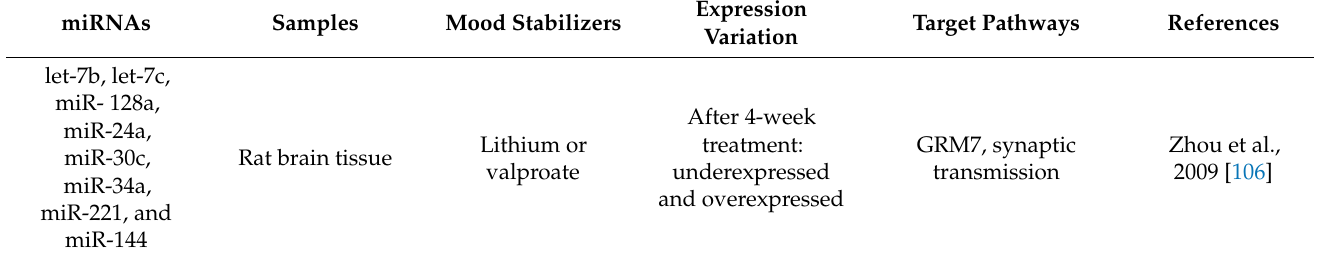
Table 2. MicroRNAs and response to mood stabilizers in preclinical studies on animal models of bipolar